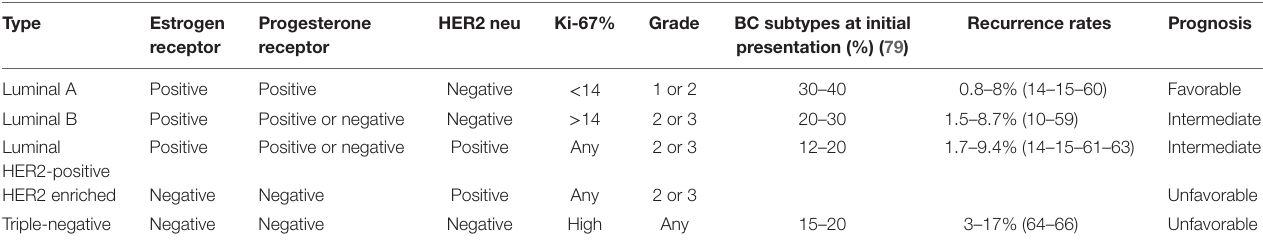
TABLe 1 | Recurrence rates according to breast cancer molecular subtypes.